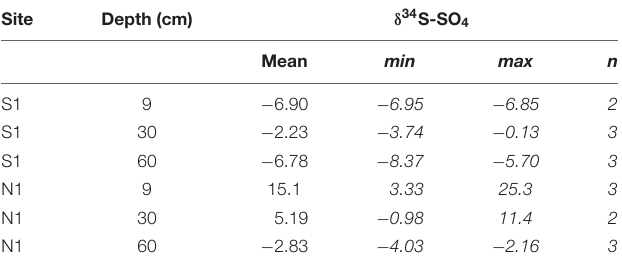
TABLE 4 | δ 34 S-SO 4 in water from the active layer in polygons S1 and N2. Site Depth